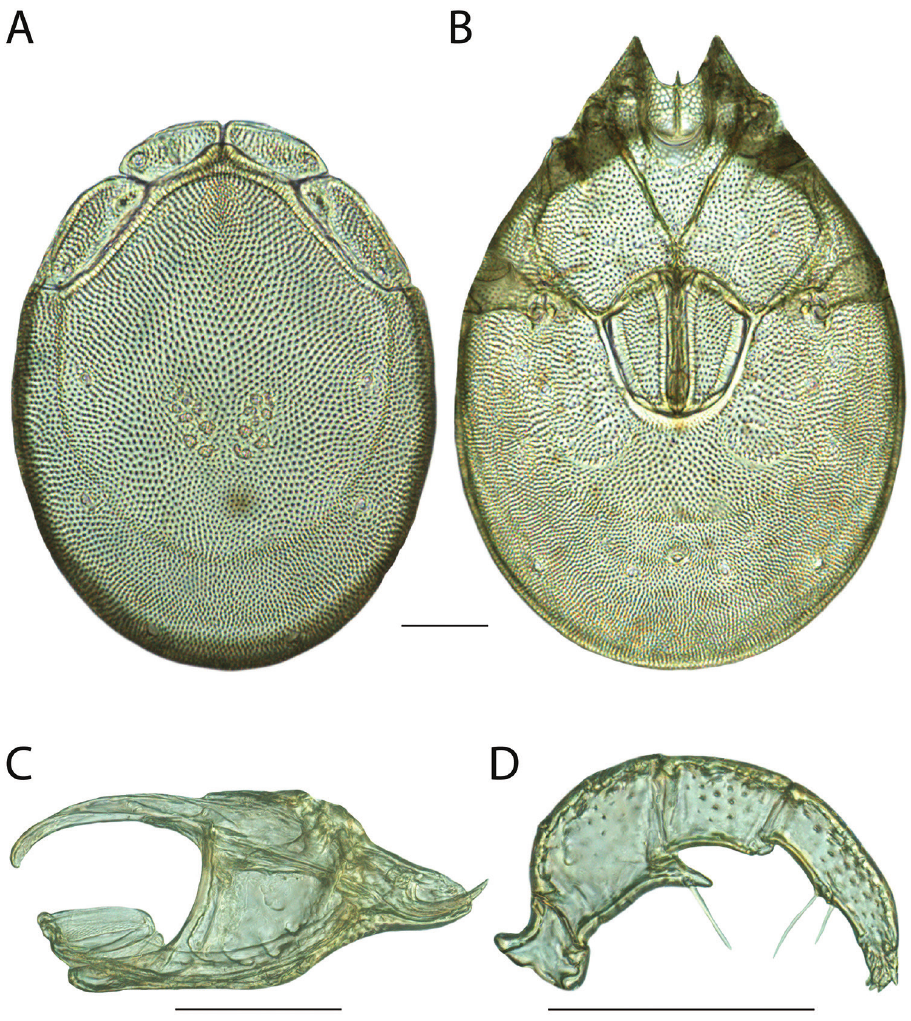
Figure 57. Torrenticola dimorpha sp. n. female: A dorsal plates B venter (legs removed) C subcapitulum D pedipalp (setae not accurately depicted). Scale = 100